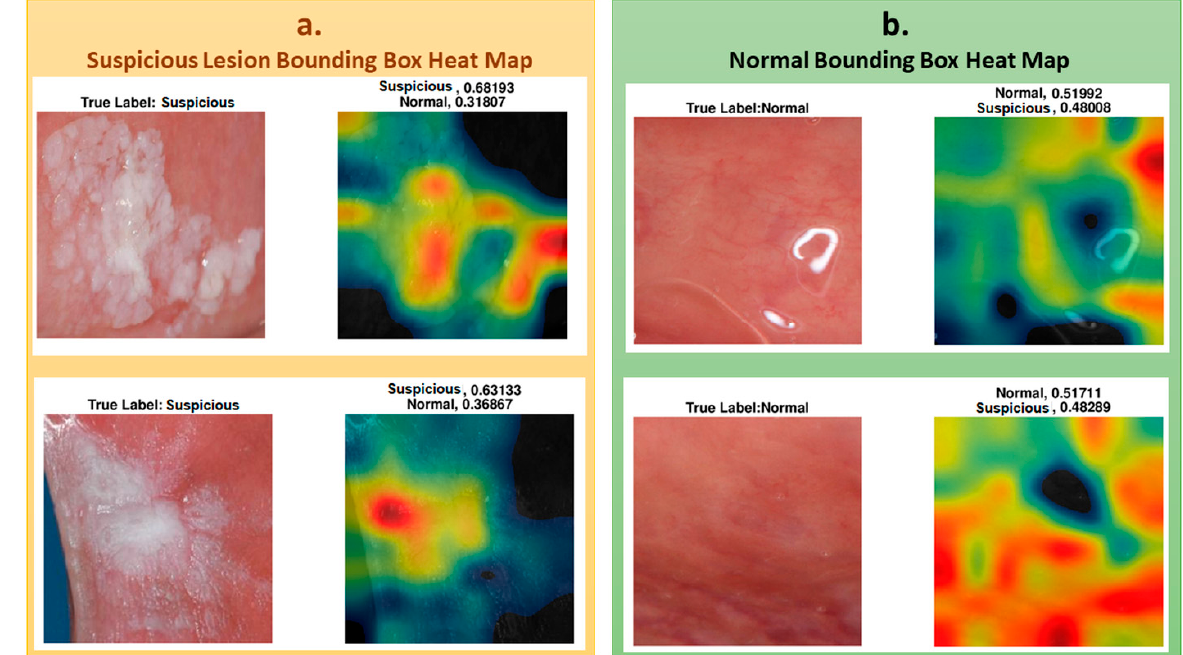
Figure 6. ( a ) Heat maps overlaps the lesion area and accurately classified for suspicious. ( b ) Heat maps overlaps the normal area and accurately classified for normal cases.